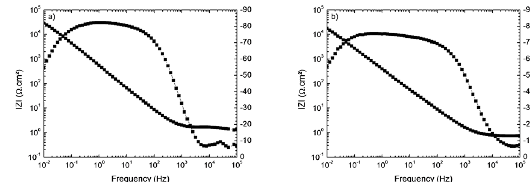
Figures 9 and Figure 10 show the Nyquist plots of TiN and TiAlN/TiAlCrN coated Ti-6Al-4V alloy in 2 M NaOH, at 25 and 60 °C.